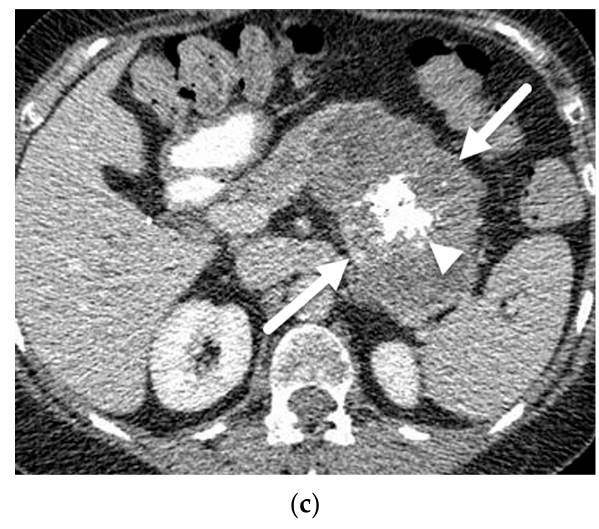
Figure 5. SCA. ( a ) Axial T2-weighted image demonstrates a hyperintense microcystic lesion in the pancreatic tail (arrows) with central scar (arrowhead). ( b ) MRCP demonstrates lobular contour of the lesion (arrow). ( c ) Axial CT post IV contrast shows the sun burst calcification in the central scar (arrowhead).